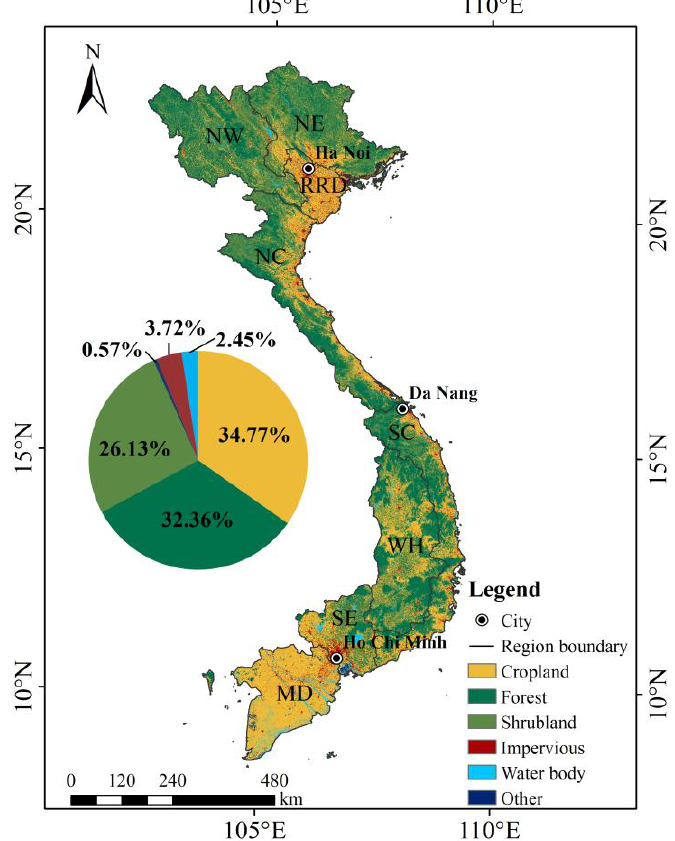
Figure 2. Land-use/land-cover map in 2020. NW: Northwest, NE: Northeast, RRD: Red River Delta, NC: North Central Coast, SC: South Central Coast, WH: West Highland, SE: Southeast, MD: Mekong River Delta.